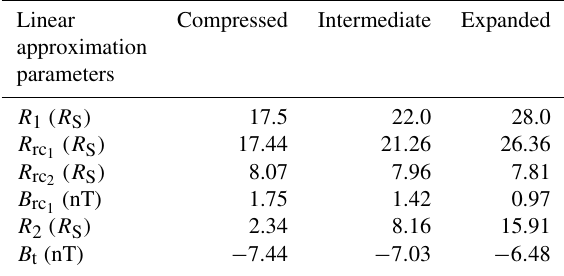
Table 5. Linear approximation model parameters for compressed, intermediate, and expanded states, corresponding to subsolar mag- netopause distances of 17.5, 22, and 28 R S , respectively. Linear Compressed Intermediate